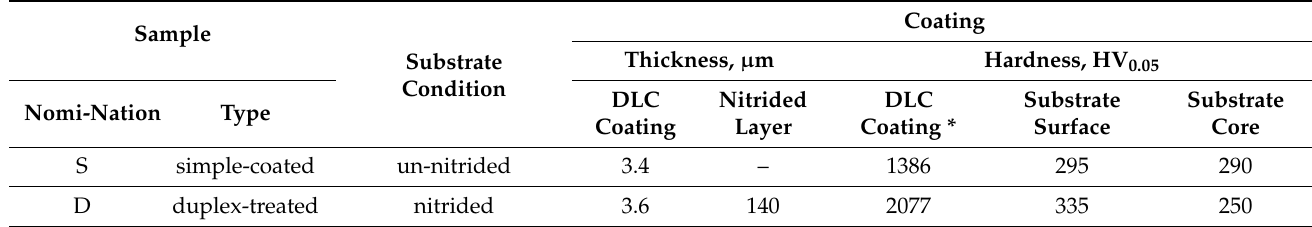
Table 1. Sample nomination and characteristics of the multilayered DLC coating.